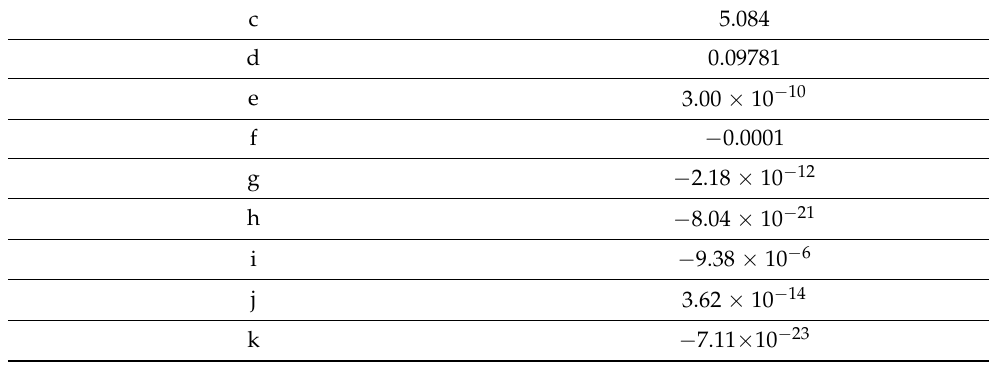
Table 5. Correlation data used for correlation